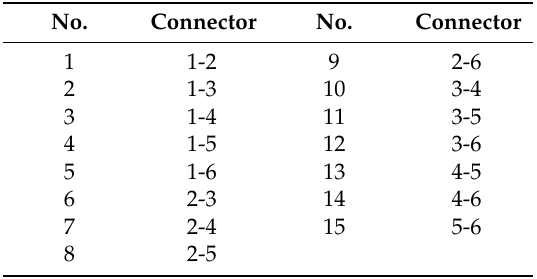
Table 1. Setup of inter-disk short circuit (SC) fault in middle 10-disk windings.